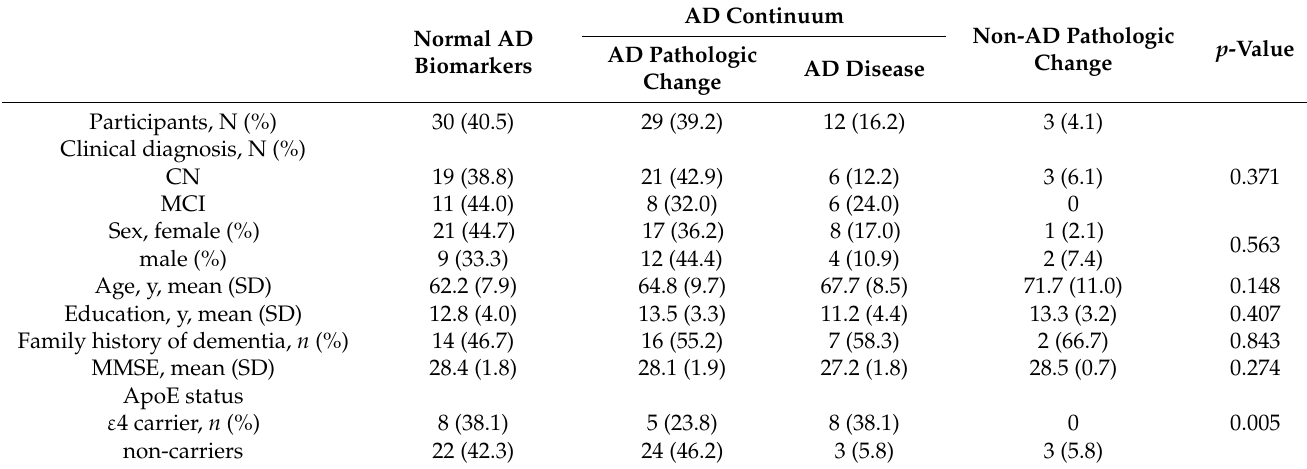
Table 3. Participant characteristics at baseline by AT(N) biomarker categories.